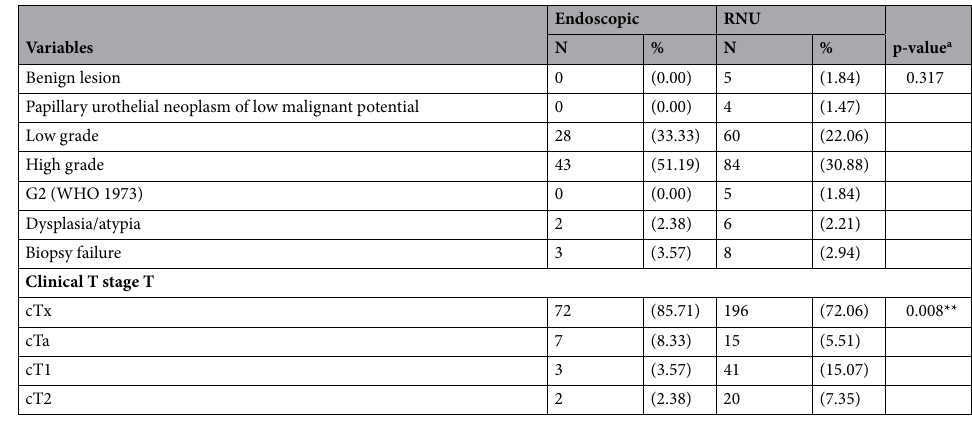
Table 1. Baseline demographic data of endoscopic and nephroureterectomy (RNU) managed UTUC. a Chi- Squared test calculated for the difference Variables. b Student’s t-test calculated for the difference in means. *< 0.05. **< 0.01.